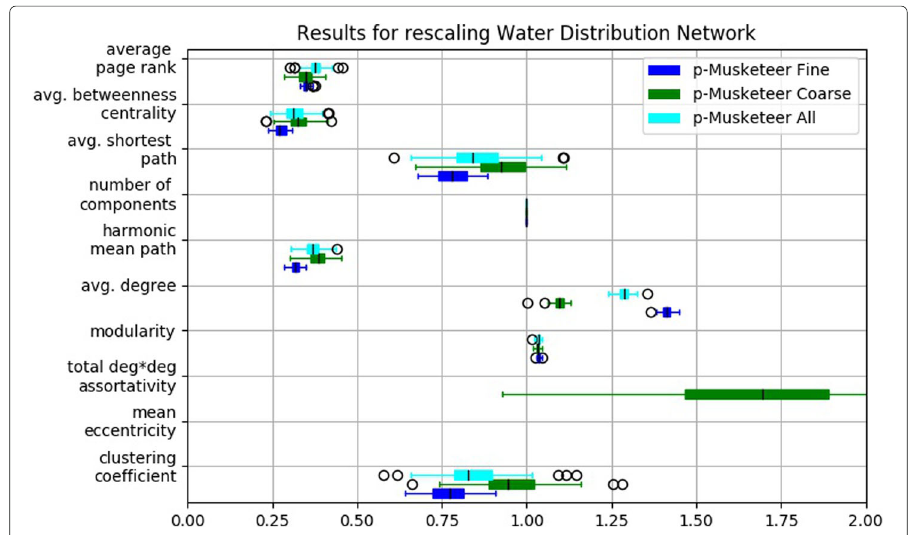
Fig. 19 Computational results for finite-element graph with 4704 nodes and 13427 edges rescaled to at least 12700 nodes and 36000 edges